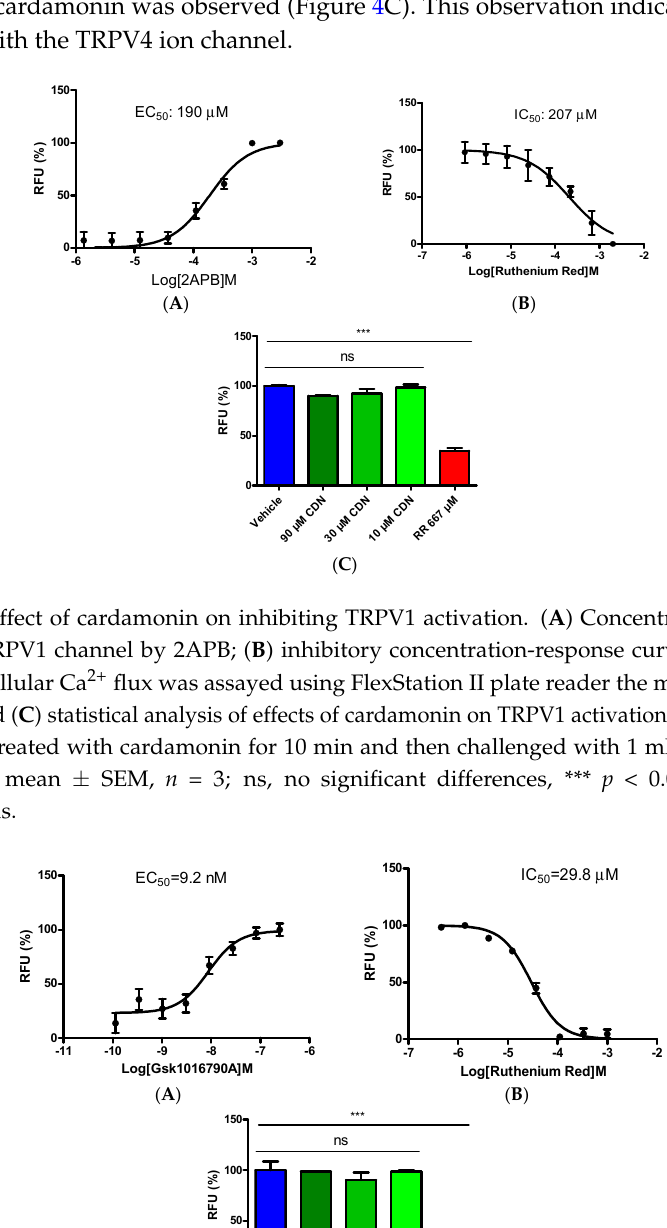
Figure 4. Assessment of cardamonin on TRPV4 activation. ( A ) Stimulating concentration-response curve of GSK1016790A on TRPV4 activation; ( B ) inhibitory concentration-response curve for ruthenium red (RR) on blocking TRPV4 activation. RR was added to the cells 10 min prior to 83 nM GSK1016790A stimulation. Calcium-flux measurement was conducted at 24 °C; and ( C ) statistical analysis of calcium signal in HEK293/TRPV4 cells treated with or without cardamonin. Data represent mean ± SEM, n = 3; ns, no significant differences, *** p < 0.001, by one-way ANOVA analysis.